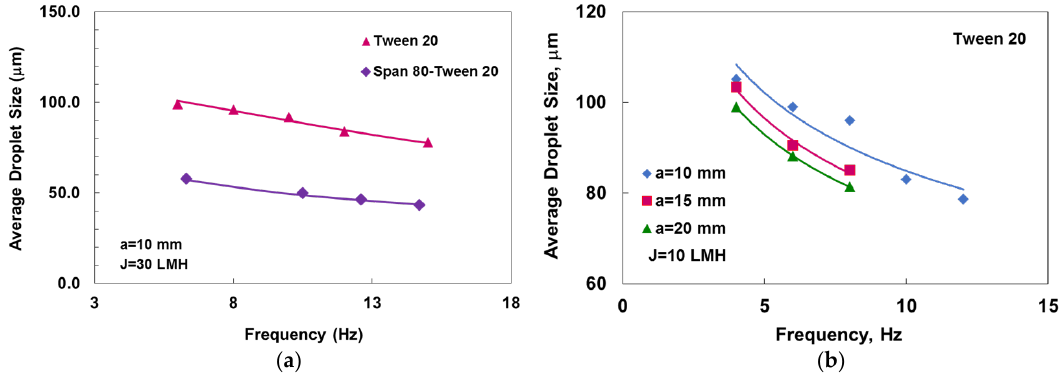
Figure 2. Change of droplet size with oscillation frequency. ( a ) Effect of surfactants; ( b ) effect of amplitude.